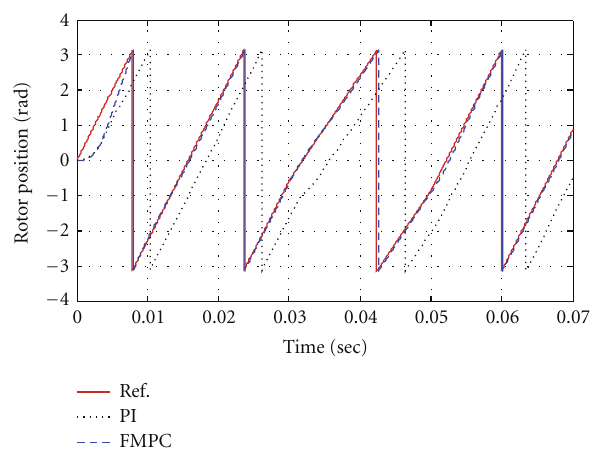
Figure 5: Rotor position response of the PMSM system based on FMPC and PI controllers.